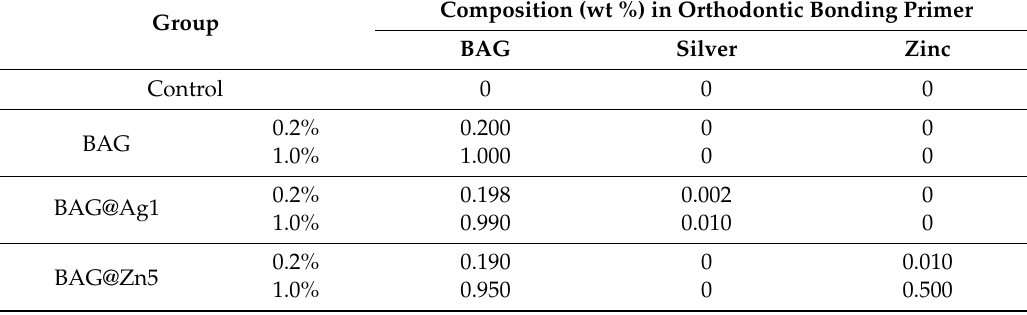
Table 4. Sample group in this